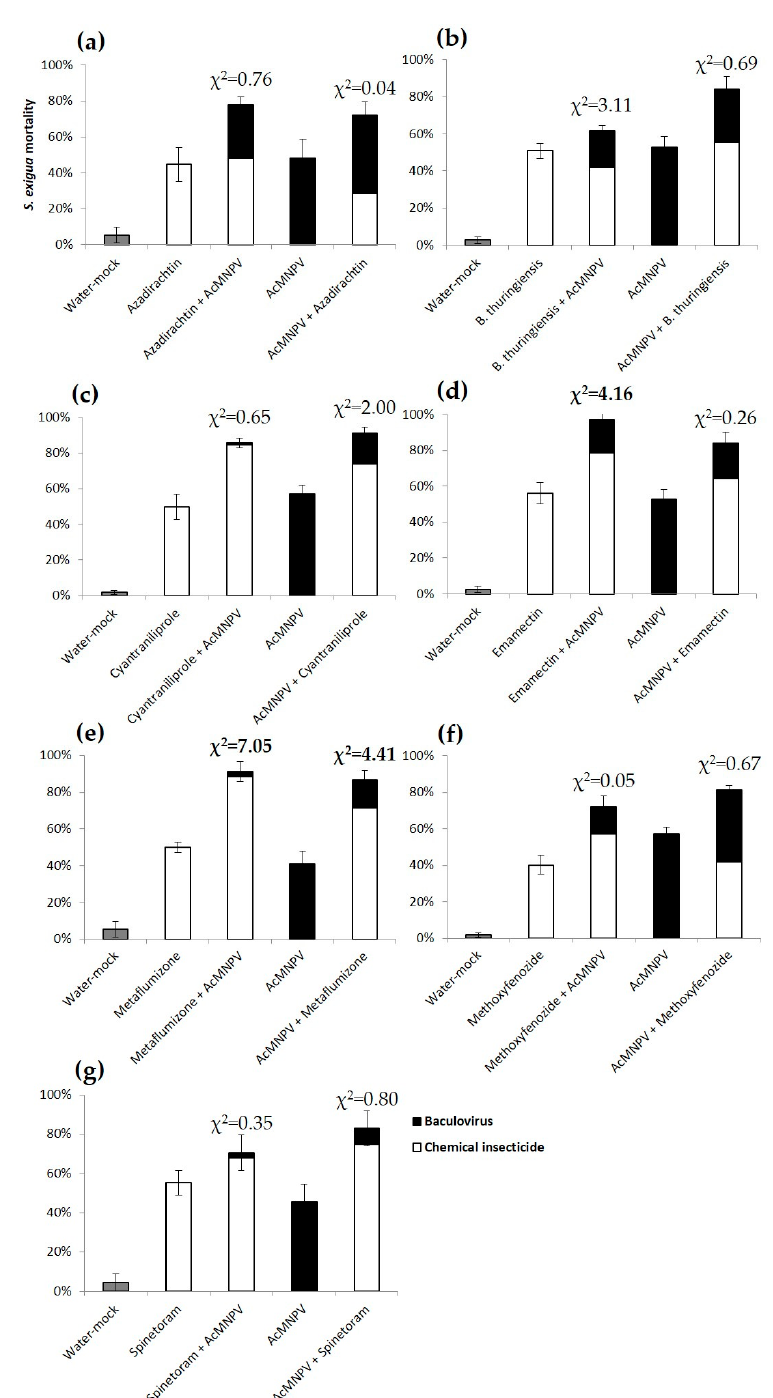
Figure 1. Mortality (%, mean ± SEM) of Spodoptera exigua second instar larvae provided with the LC 50 of chemical insecticides, ( a ) azadirachtin; ( b ) B. thuringiensis ; ( c ) cyantraniliprole; ( d ) emamectin; ( e ) metaflumizone; ( f ) methoxyfenozide; ( g ) spinetoram; the LC 50 of AcMNPV or the sequential feeding of both over 10 min, and then maintained ad libitum on a semi-synthetic diet. The cause of death is represented by white bars for chemical insecticides and black bars for AcMNPV. Mock water controls are represented by gray bars. Significant χ 2 showing synergy are in bold. Tabular χ 2 with df = 1 and p ≤ 0.05 is